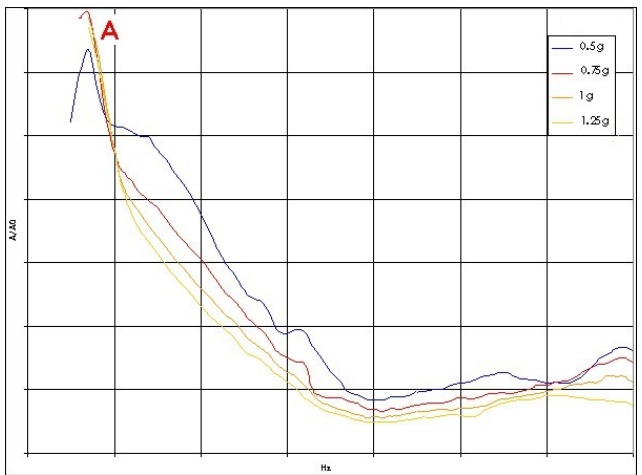
Figure 14. Sprung mass frequency response due to the front wheel frequency sweep. A piezometric accelerometer is located at the centre of gravity.